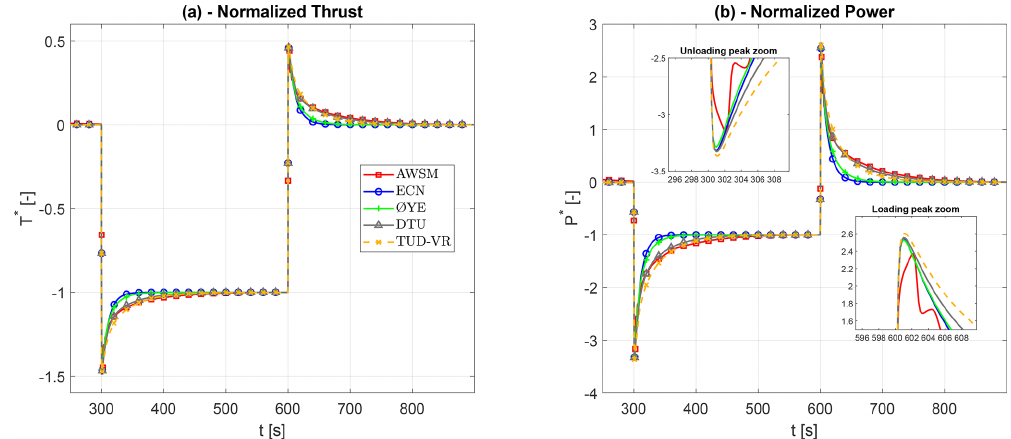
Figure 4. Normalized rotor aerodynamic thrust (a) and power (b) response to the blade pitch steps near rated conditions.